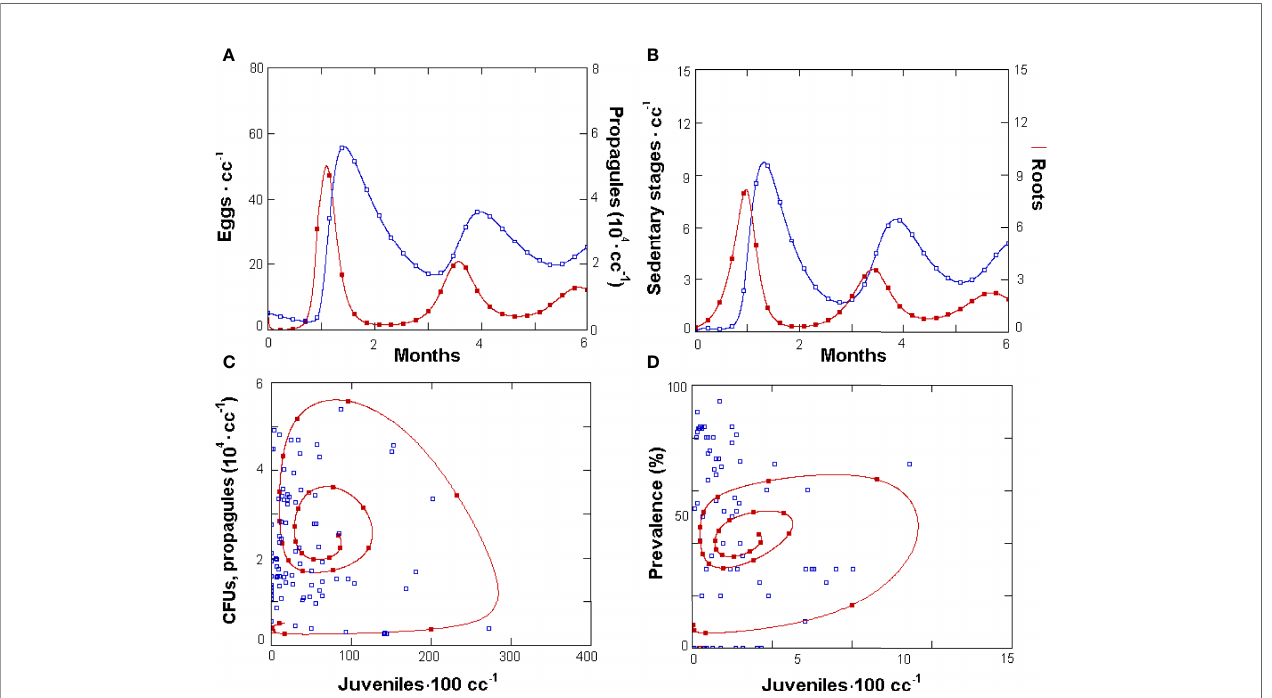
FIGURE 3 | Density changes simulated by GPNRd in a 6-month period for Meloidogyne incognita eggs ( fi lled symbols) and Pochonia chlamydosporia propagules · cc soil -1 (A) , and for feeder roots · cc soil -1 ( fi lled squares) and nematode sedentary stages (B) . Phases space plot (C) of GPNRd-simulated propagule numbers ( fi lled symbols) and observed mean soil and roots CFUs · cc -1 (empty squares) vs . simulated and observed J2 · 100 cc soil -1 , respectively. (D) Phases space plot of GPNRd-simulated ( fi lled symbols) and measured fungus prevalence in eggs (for initial points and constants see Table 1